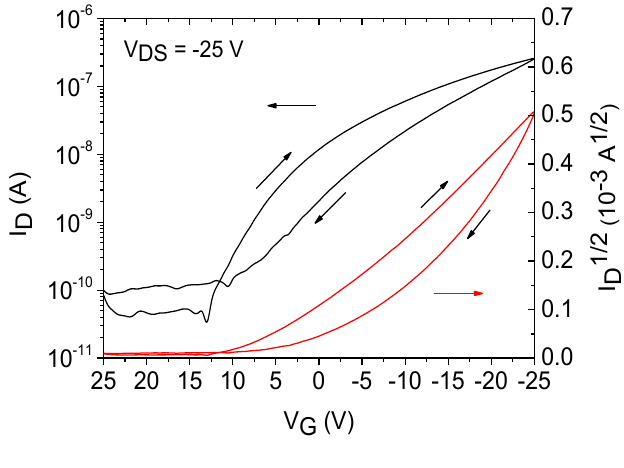
Figure 7. Transfer curve of an organic transistor based on FS111 on SiO